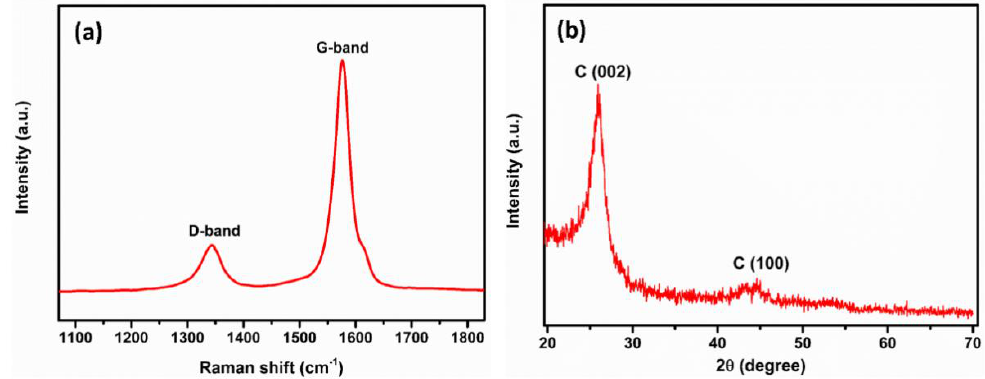
Figure 1. Raman spectra ( a ) and XRD pattern of the pristine carbon nanotubes (CNT) ( b ).